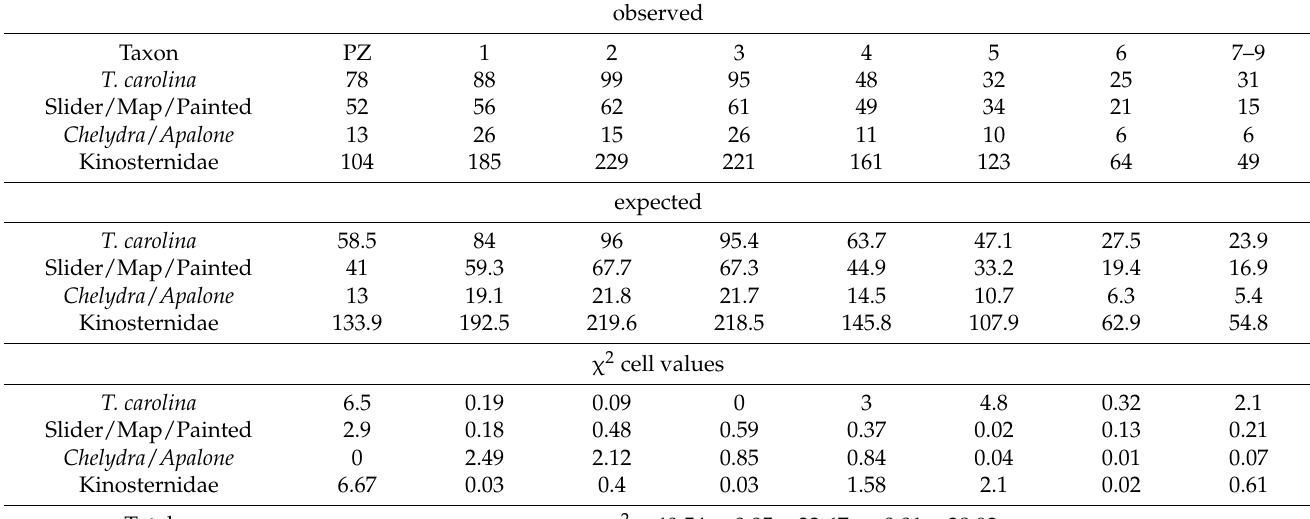
Table 6. Combined taxon frrequency by level.